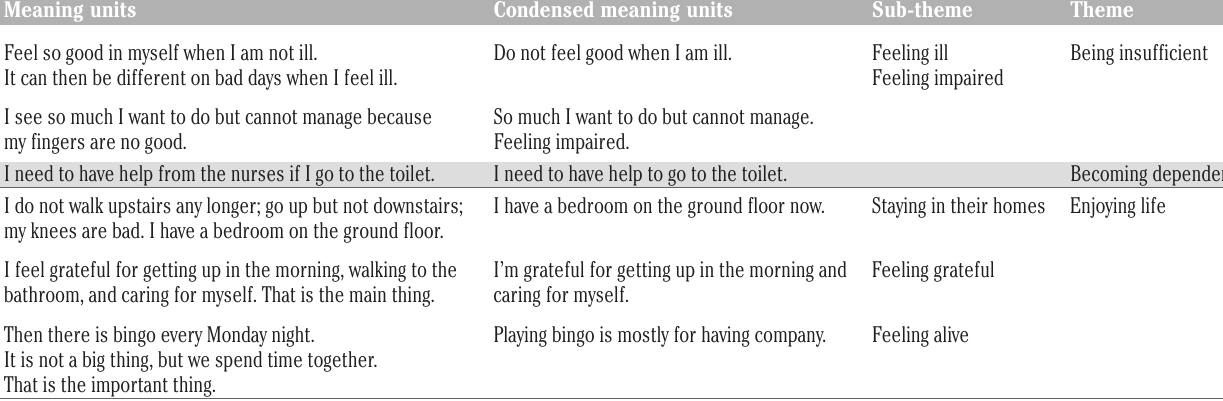
Table 2. Example of the analytical process. Meaning units Condensed meaning units Feel so good in myself when I am not